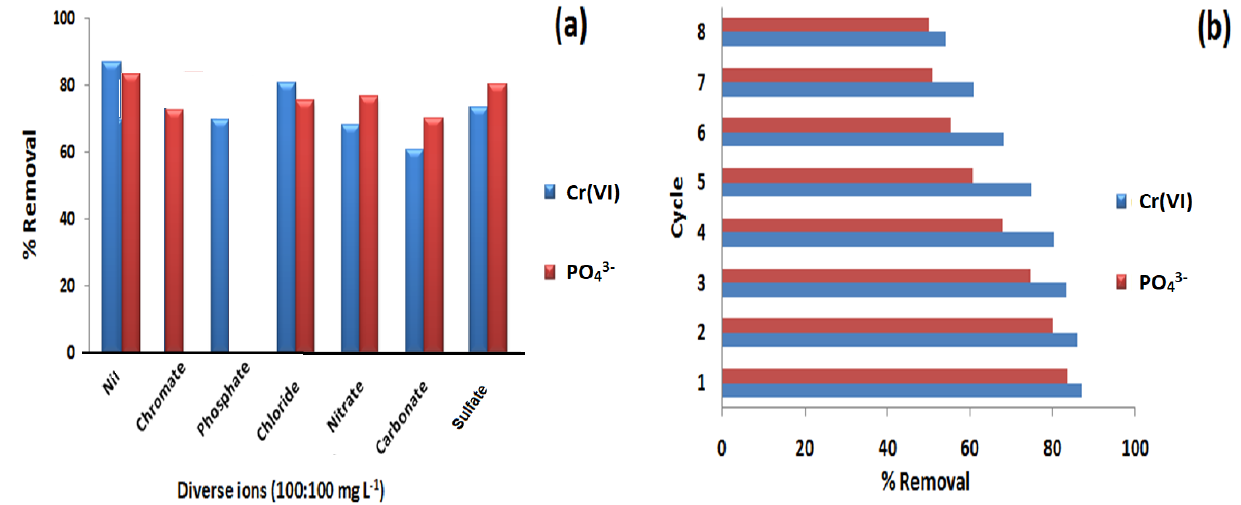
Figure 10. ( a ) Effect of diverse ions and ( b ) regeneration cycles after adsorption of Cr(VI) and phosphate ions on Fe–CTB.